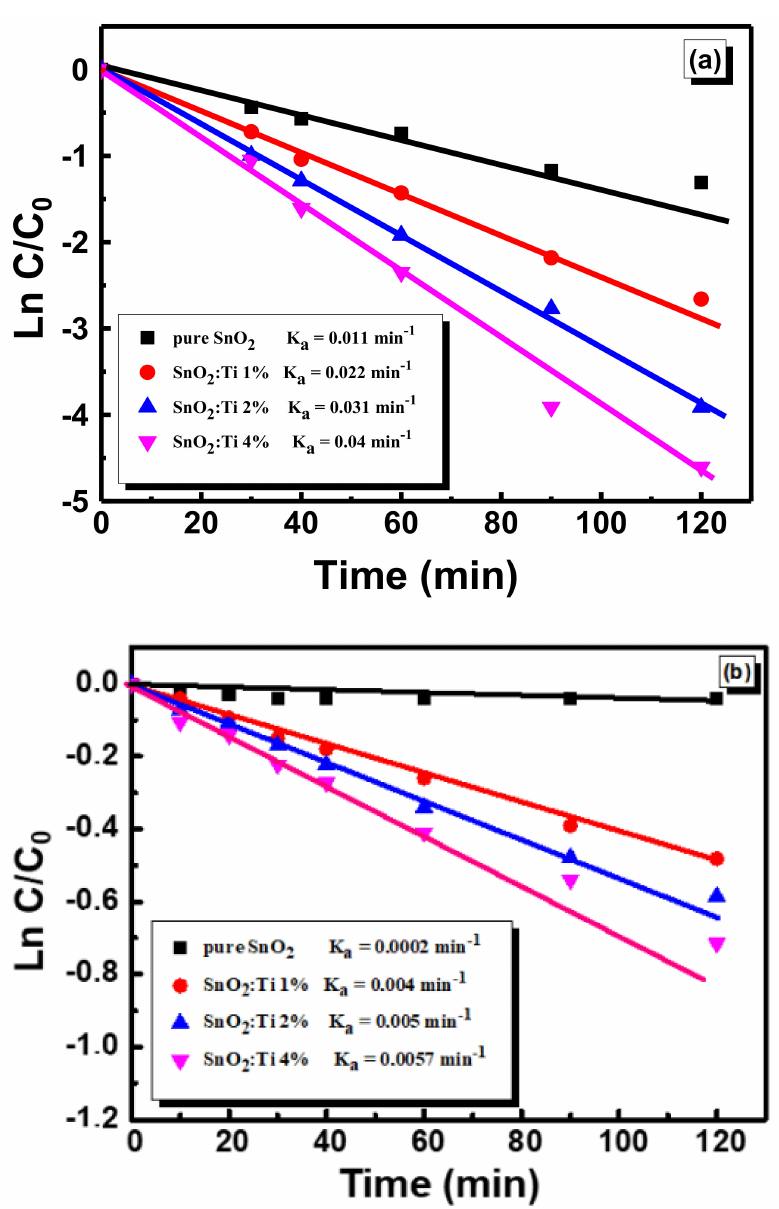
Figure 10. Plots of Ln (C/C 0 ) as a function of the irradiation time for Ti–SnO 2 based photocatalysts ( a ) under UV irradiation and ( b ) under visible